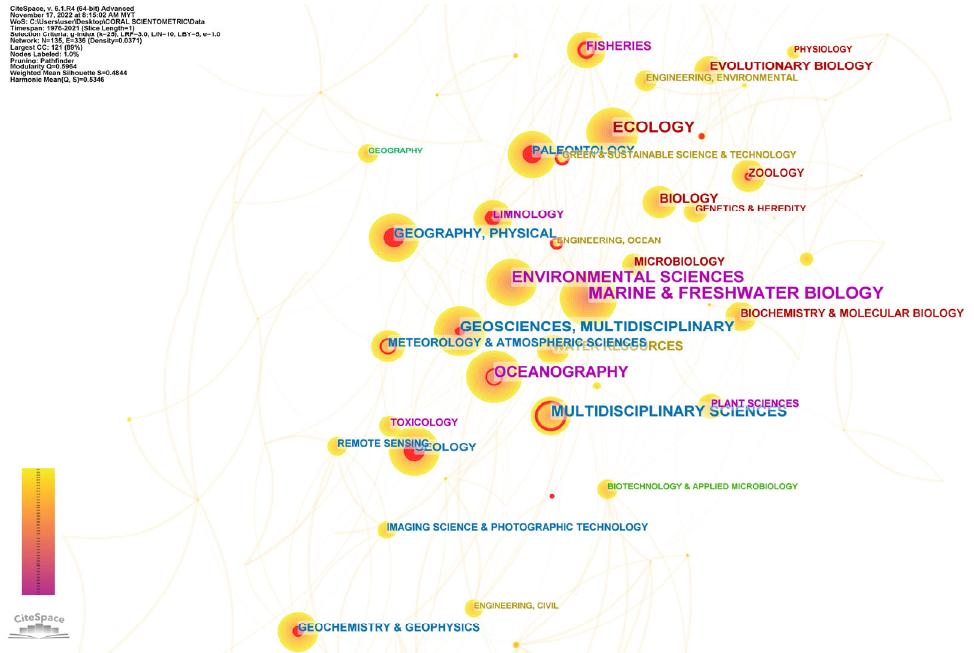
Figure 6. Network of linked research disciplines. The sizes of the modes are proportional to the frequency of the subject category cooccurrence. The thickness of the lines between the two nodes is proportional to the strength of the linkages between the two research disciplines.